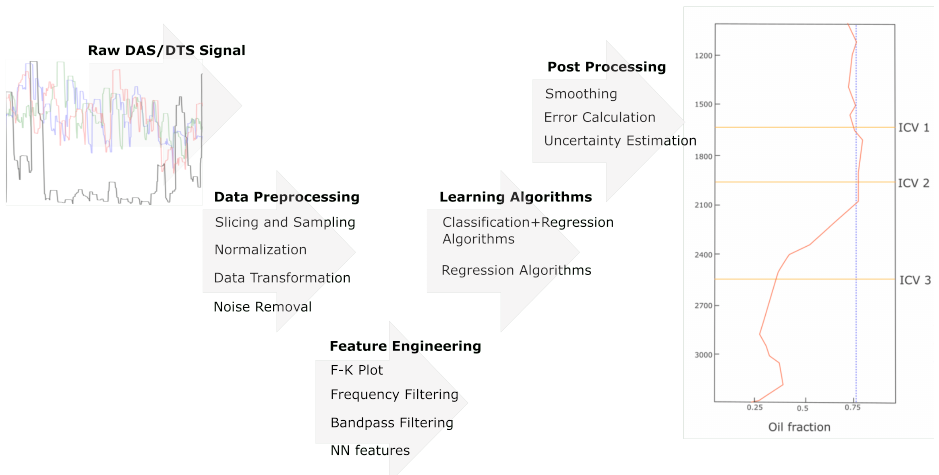
Figure 12. The common workflow of machine learning-based techniques for multiphase fluid flow